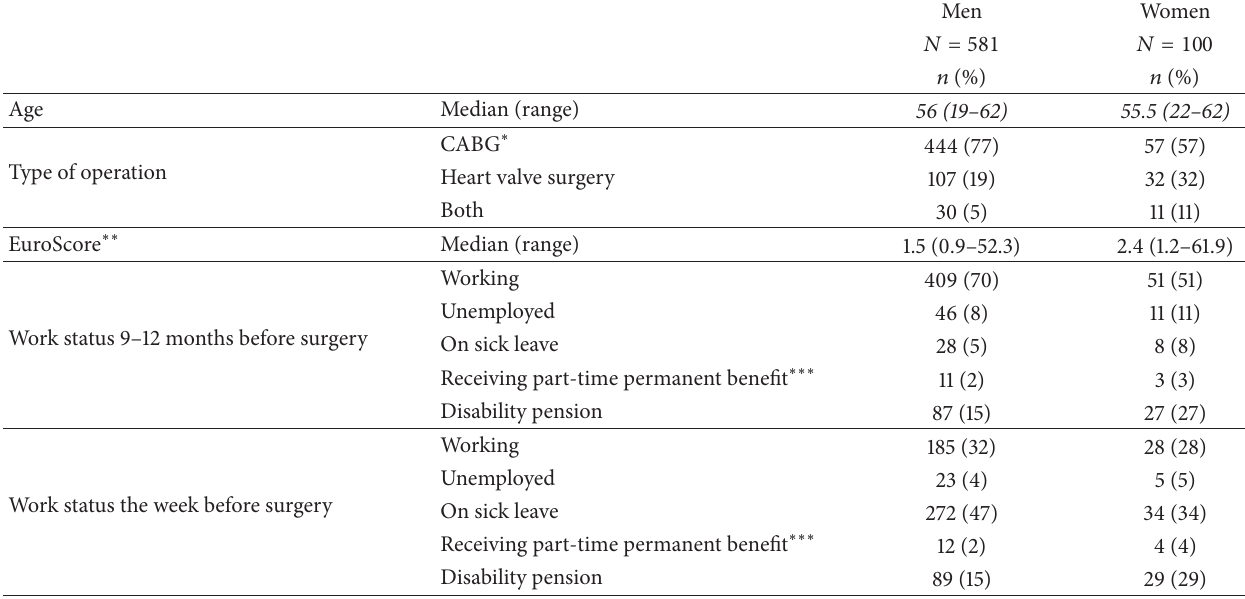
Table 1: Characteristics of patients undergoing coronary artery bypass surgery and/or heart valve surgery in the North Denmark Region, from 2003 to 2007; numbers and percentages.